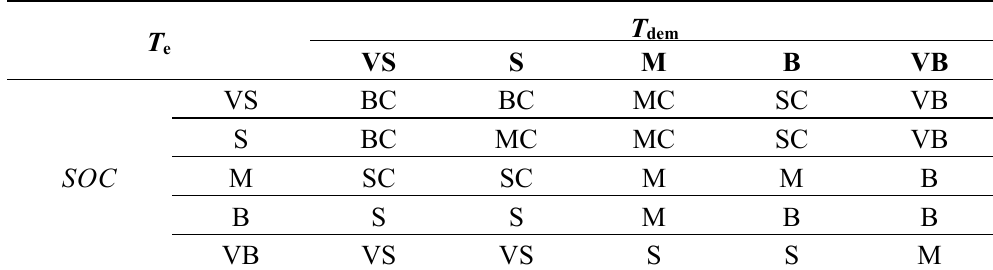
Table 3. Summary of fuzzy